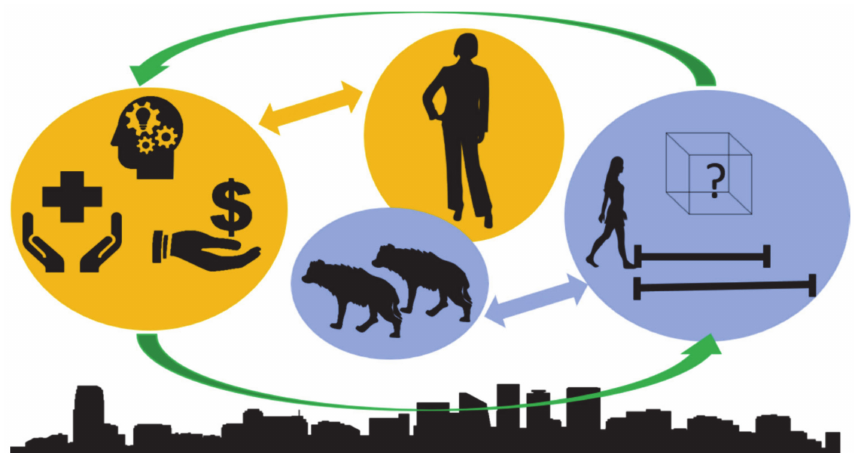
Figure 4. Conceptual model of hyena dynamics, human dynamics, and where they influence one another. In urban areas where humans and hyenas overlap (center), humans integrate economics, perceptions and beliefs, and public health, whereas hyenas integrate behavioral responses to humans (e.g., flight initiation distance tests) and problem-solving abilities (e.g., puzzle boxes). How both outwardly behave in response to these factors further influences